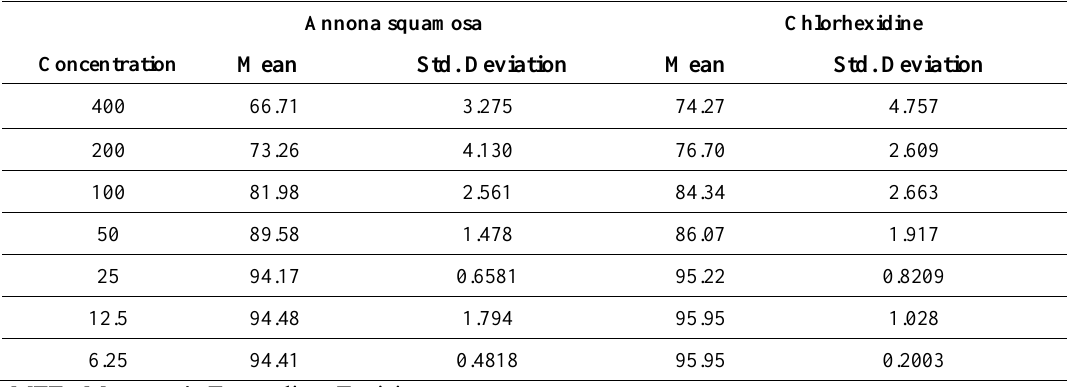
Table 1: Cell viability of the Annona squamosa extract and the positive control chlorhexidine at